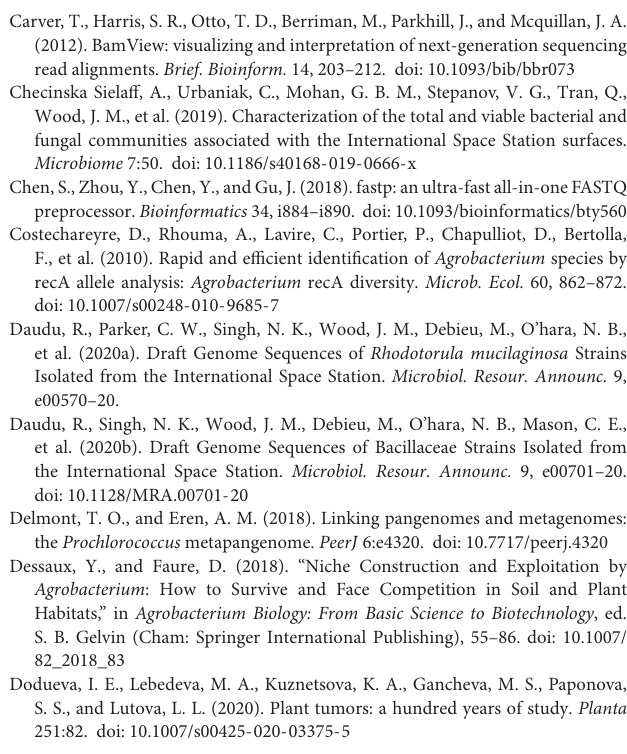
Supplementary Table 2 | Differential biochemical characteristics among A. tomkonis strains.